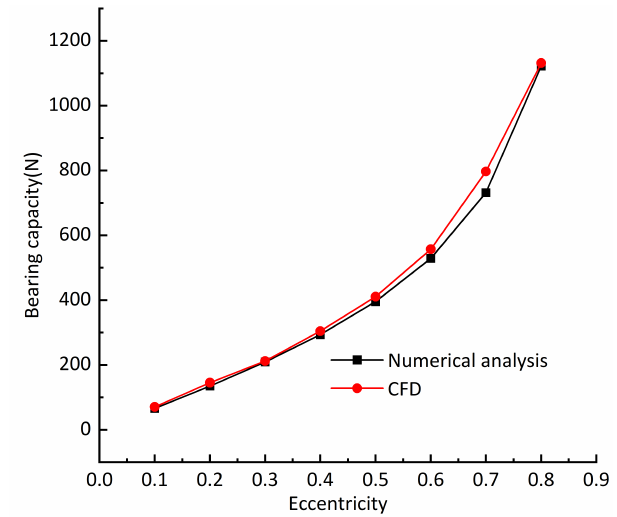
Figure 5. Bearing capacity under two